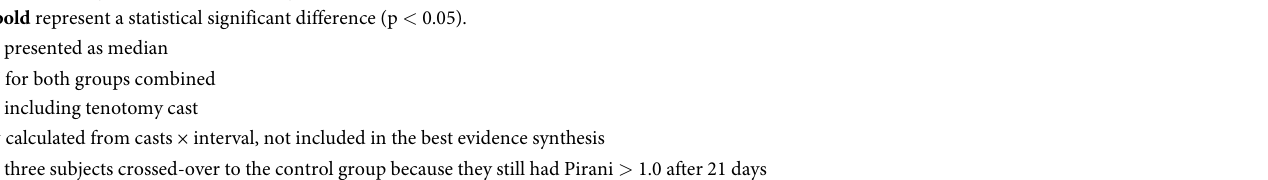
Table 5. Best evidence synthesis of outcome measures.